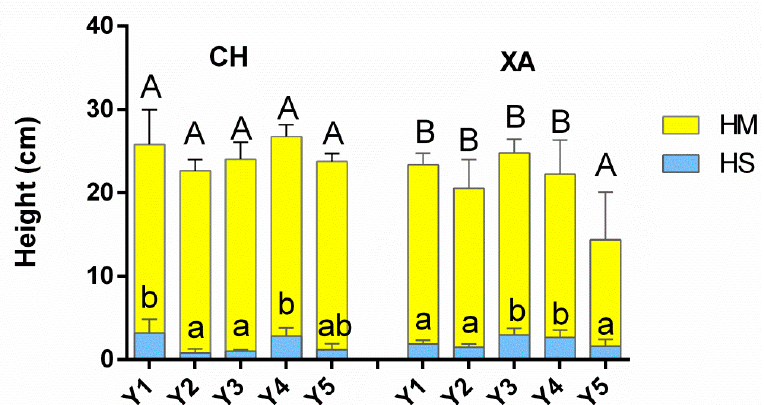
Figure 2. Foamability measurements of the different Chardonnay (CH) and Xarel.lo (XA) base wines made with different yeasts strains, Saccharomyces cerevisiae (Y1, Y2, Y3) and non- Saccharomyces , M. pulcherrima (Y4) and T. delbrueckii (Y5), using the Mosalux procedure. HM indicates the maximum height reached by the foam and HS the height in a steady state. Different letters indicate significant differences between samples with different yeasts. Uppercase letters for HM and lowercase letters for HS. Samples (n = 2).